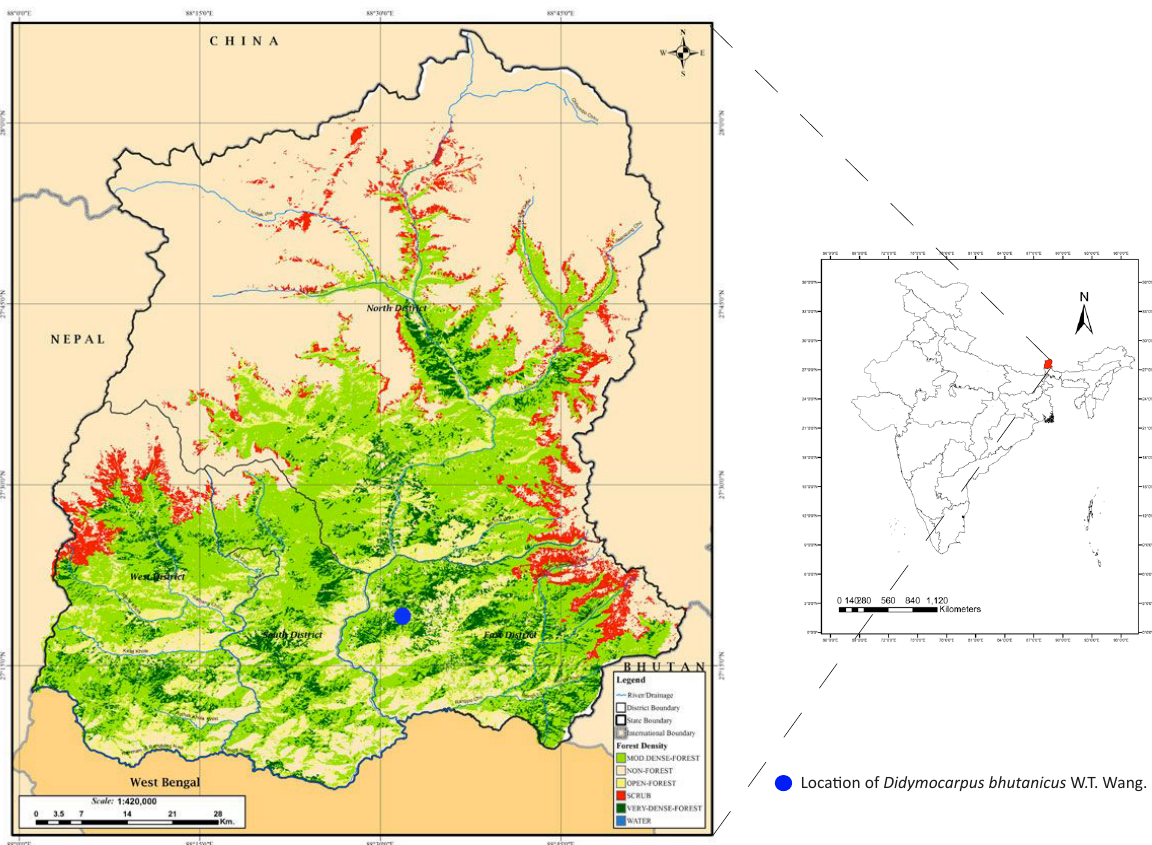
Figure 1. Location of Didymocarpus bhutanicus W.T. Wang near Rakdong area, East District,